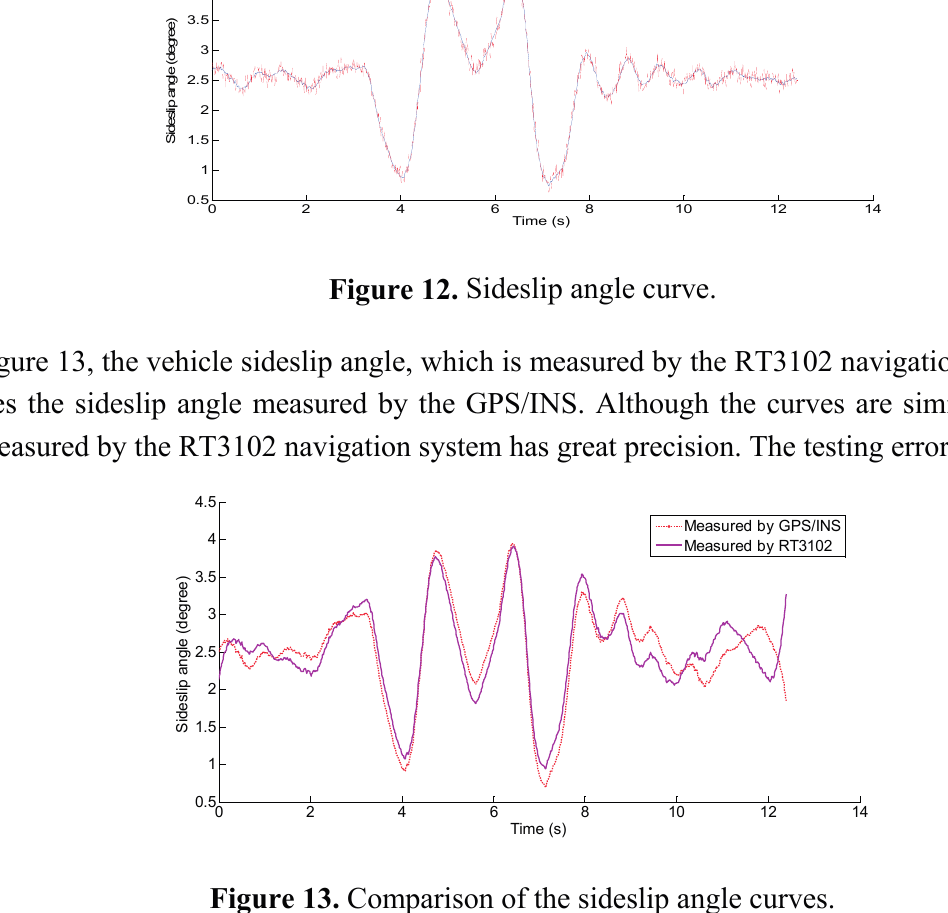
Figure 13. Comparison of the sideslip angle